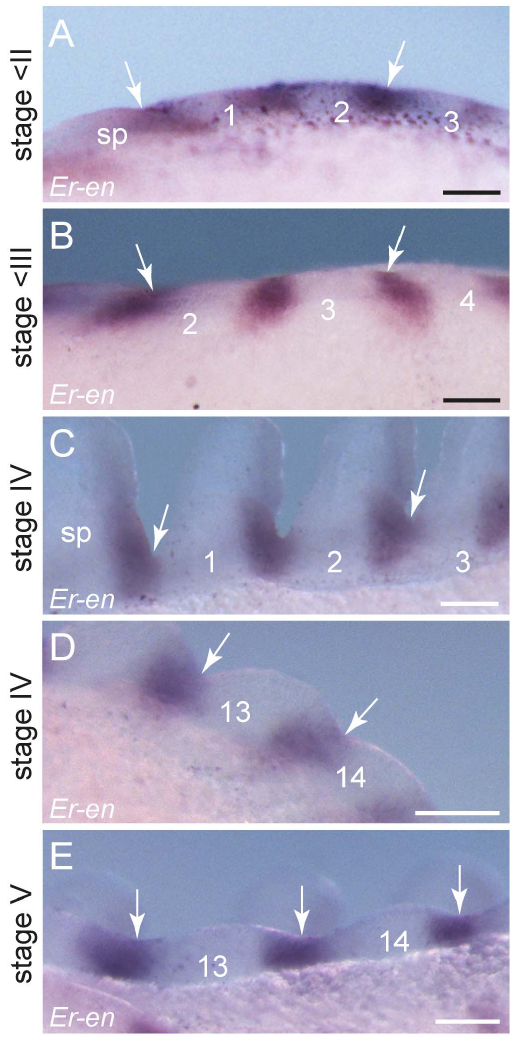
Figure 5. Spatial relationship between segmental furrows and repeated engrailed domains in embryos of E. rowelli . Anterior is left in all images. Leg-bearing segments and corresponding limbs are numbered. Arrows indicate the position of segmental furrows in embryos of E. rowelli at subsequent developmental stages in ventral (A, C, D), dorsal (B), and ventro-lateral perspectives (E). Abbreviation: sp , anlage of the slime papilla/slime papilla segment. Scale bars: 100 m m (A, B, D, E,), 125 m m